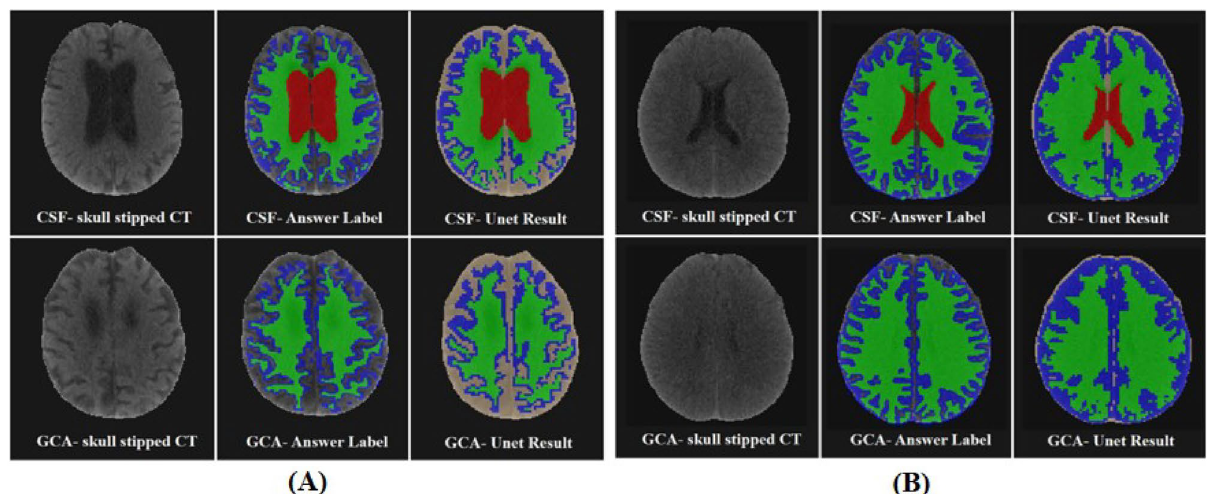
Figure 2. Sample of segmentation result ( A ) Alzheimer’s dementia ( B ) Normal control. GCA global cortical atrophy, CSF cerebrospinal fluid. Green = white matter, blue = gray matter, red = CSF.